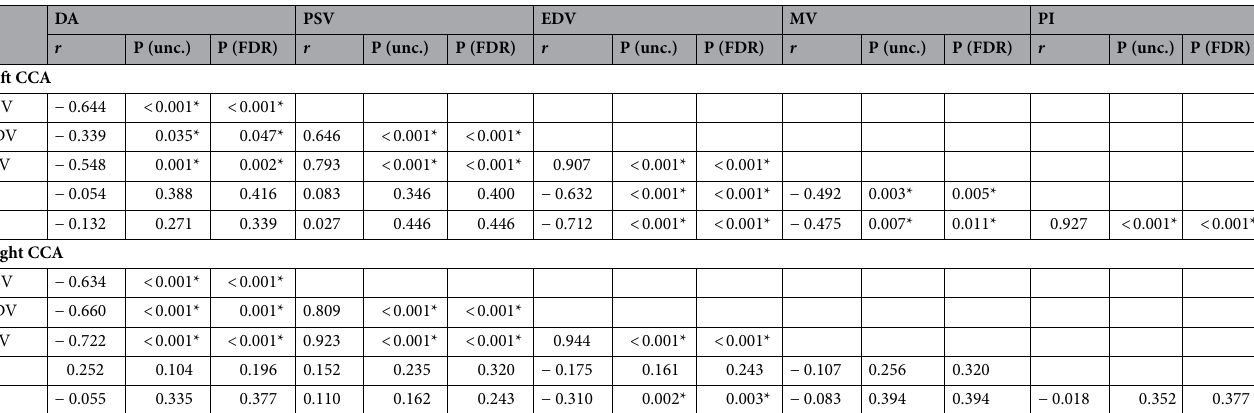
Table 1. Correlation matrix within sided ultrasonographic parameters. DA diameter of artery, CCA common carotid arteries, EDV end-diastolic velocity, MV mean velocity, P (unc.) uncorrected p values of bootstrapping statistics, PI pulsatility index, r average correlation coefficient across bootstrap iterations, PSV peak systolic flow velocity, RI resistance index, P (FDR) p values of bootstrapping statistics with FDR-correction. *A statistically significant correlation after FDR